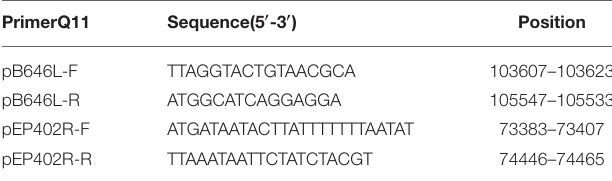
TABLE 1 | Primers used for the recombinant standard plasmids